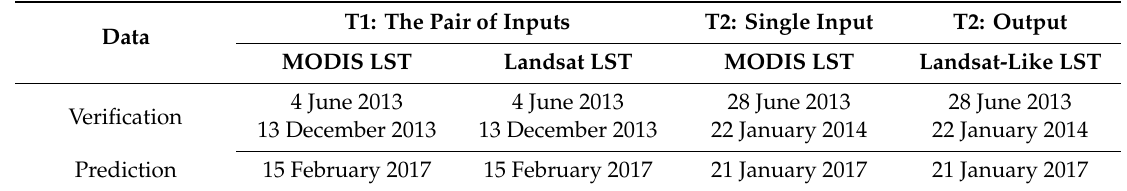
Table 2. The input and the output of the Flexible Spatiotemporal Data Fusion (FSDAF)